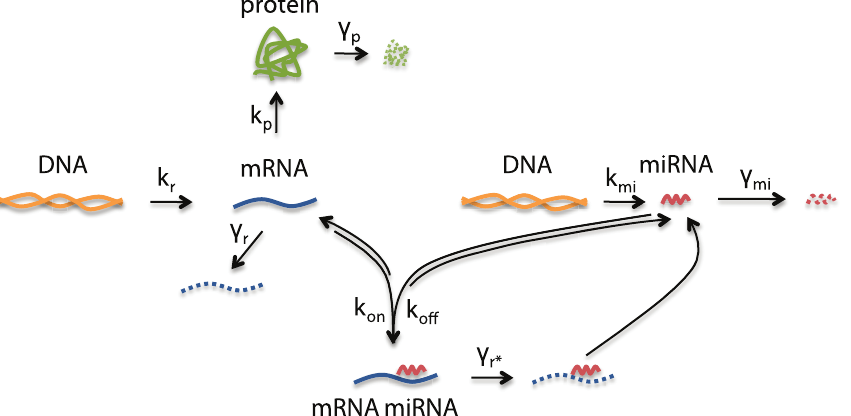
Figure 8. Post-transcriptional repression model with miRNA transcribed on a different transcript than mRNA.